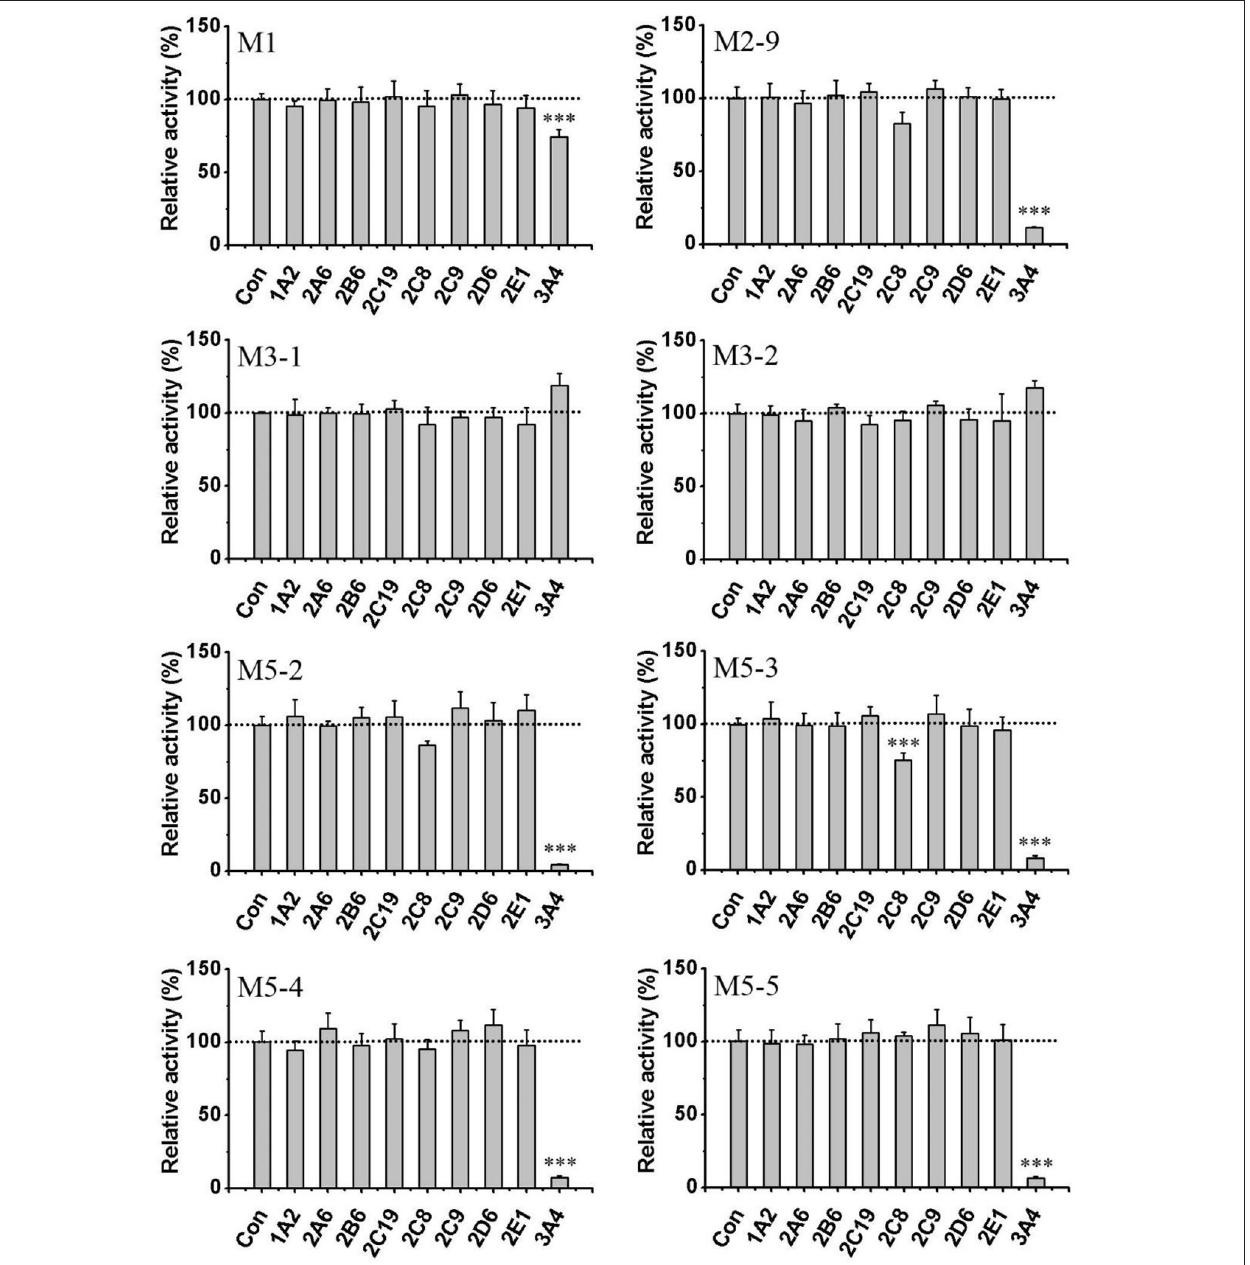
FIGURE 5 | Effects of CYP450 inhibitors on the formation of F18 metabolites in HLMs. F18 (10 µ M) was incubated with liver microsomes in the absence (as control) or presence of selective inhibitors: furafylline (10 µ M) for CYP1A2, tranylcypromine (2 µ M) for CYP2A6, ticlopidine (0.5 µ M) for CYP2B6, quercetin (10 µ M) for CYP2C8, sulfaphenazole (5 µ M) for CYP2C9, ticlopidine (10 µ M) for 2C19, quinidine (2 µ M) for CYP2D6, diethyldithiocarbamate (50 µ M) for CYP2E1, and ketoconazole (1 µ M) for CYP3A4. The inhibition of the formation of M1, M2-9, M3-1, M3-2, M5-2, M5-3, M5-4, and M5-5 is expressed as percentage of the control (absence of inhibitor) and represent the means ± S.D. of triplicate experiments. Statistical significance was assessed using one-tailed student’s t -test and is indicated with *** p <